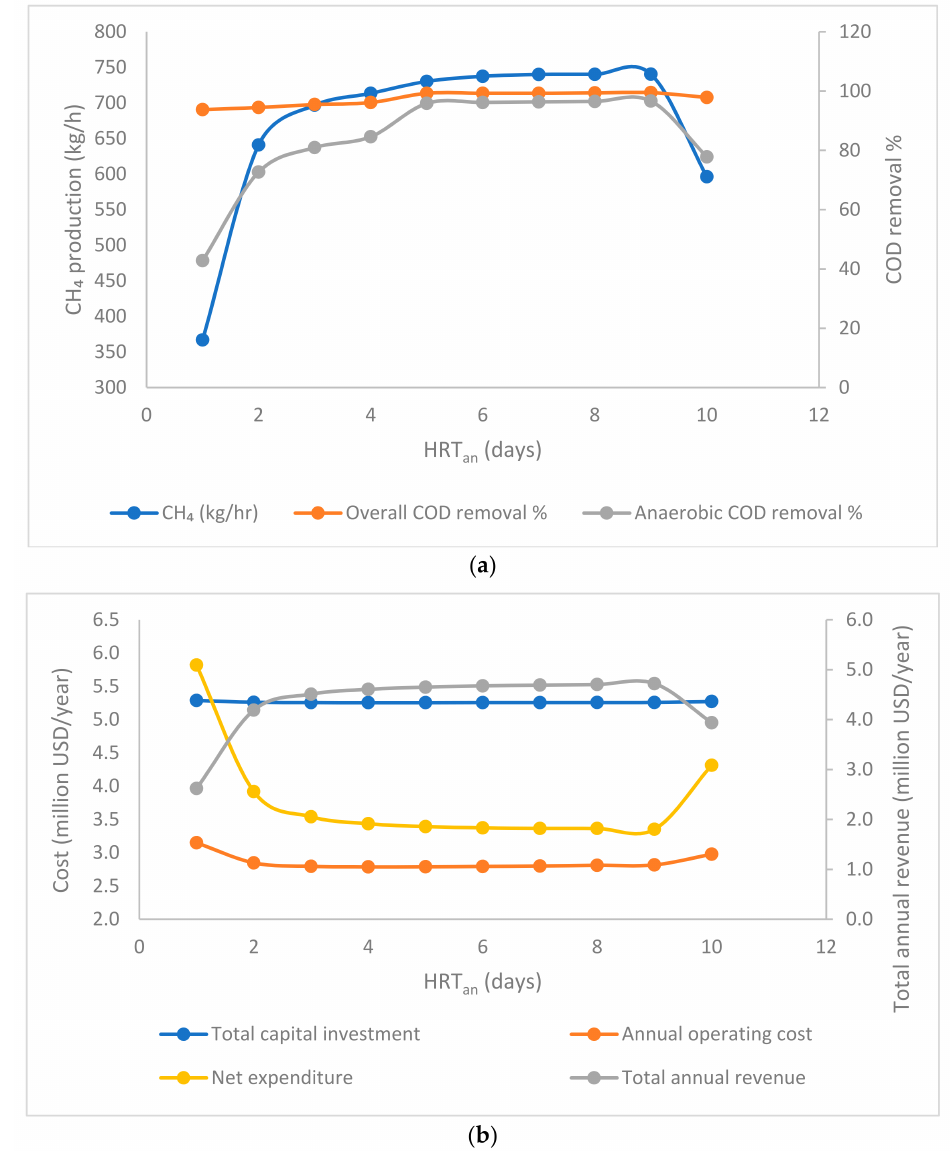
Figure 3. ( a ) Effect of HRT against methane production and COD removal %, ( b ) Effect of HRT